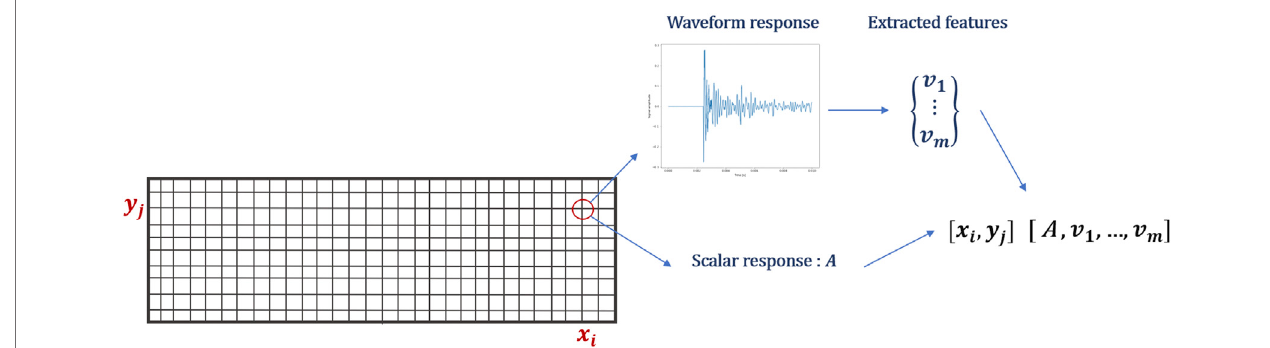
FIGURE 2 | Combining scalar and waveform responses of interpolated data.